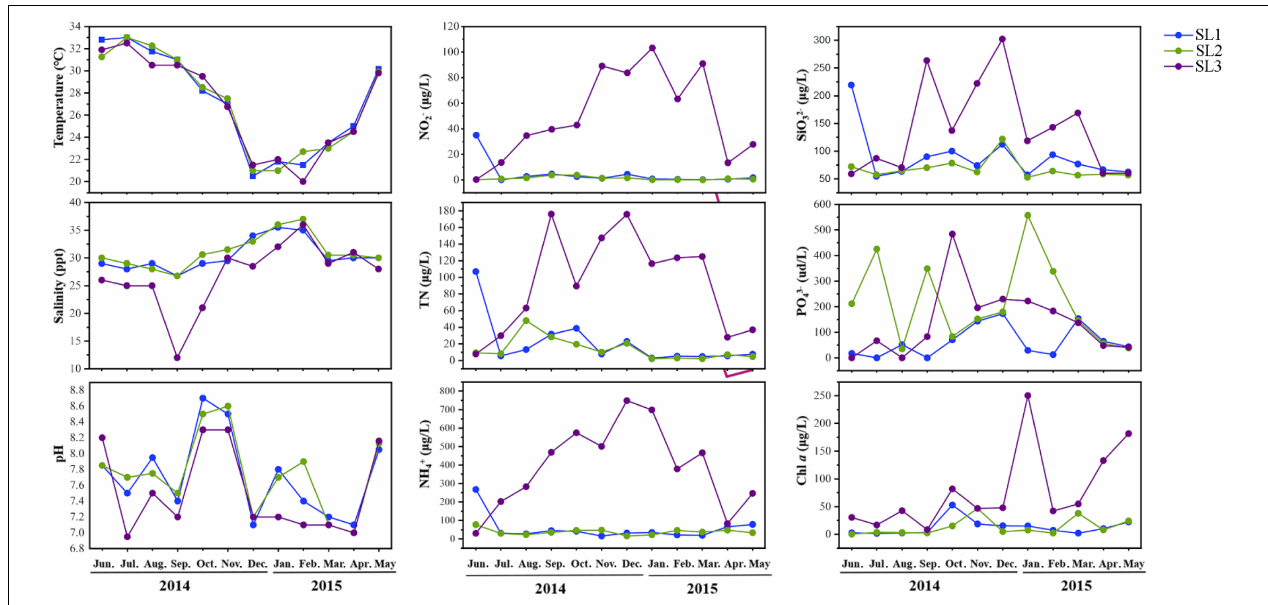
FIGURE 1 | Environmental parameters of the three stations during the studied